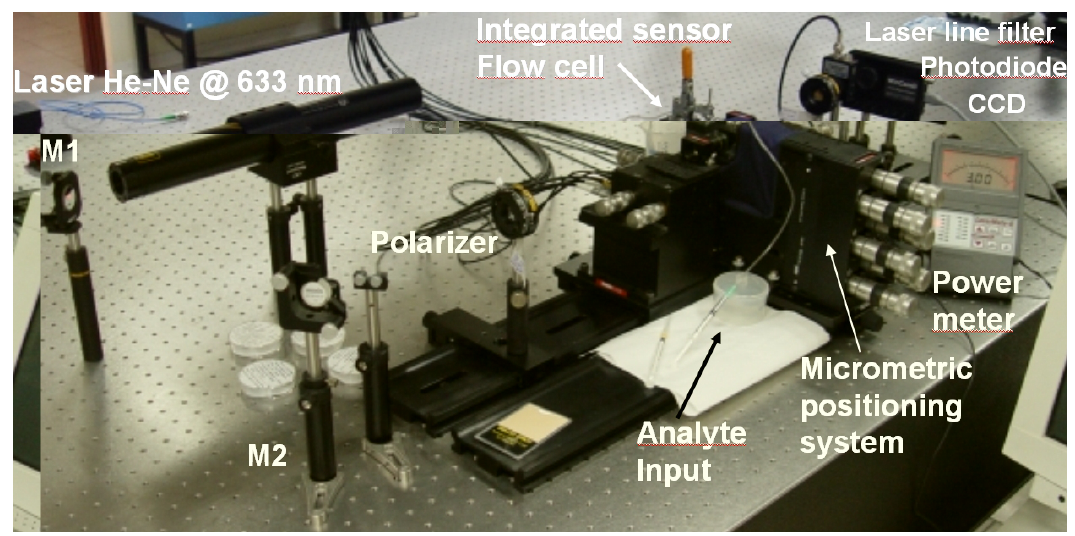
Figure 6. Waveguide coupling (with micropositioners) and measurement